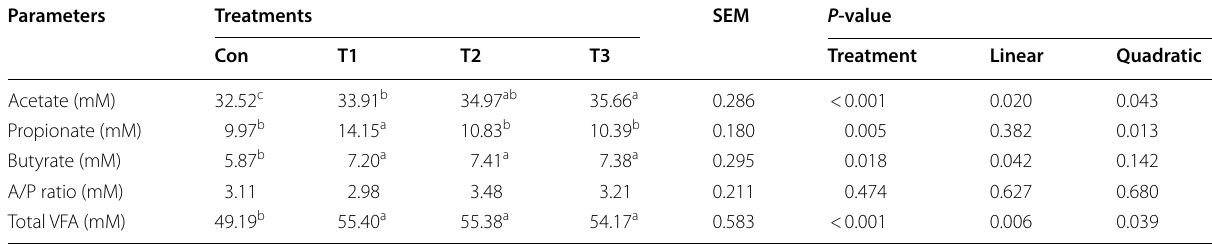
Con control (no addition), T1 0.1% E. faecium , T2 0.5% E. faecium , T3 1.0% E. faecium , SEM standard error of the mean Different superscript letters indicate a statistically significant difference. P -value, calculated probability